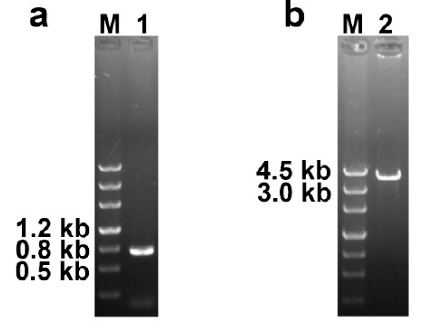
Figure 3. PCR analysis of the complementation of the Cmfhp gene. ( a ) PCR amplification of the ben gene in complementary transformants (M: DNA marker; lane 1: 754 bp fragment of the ben cassette). ( b ) PCR amplification of the Cmfhp gene in complementary transformants (M: DNA marker; lane 2: